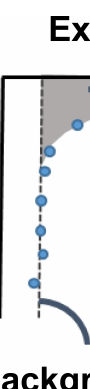
Figure B1. Definition of “excess” phosphorus (P). Schematic fig- ure showing the definition of excess phosphorus (P), which is the integrated enrichment of a P fraction compared to its background